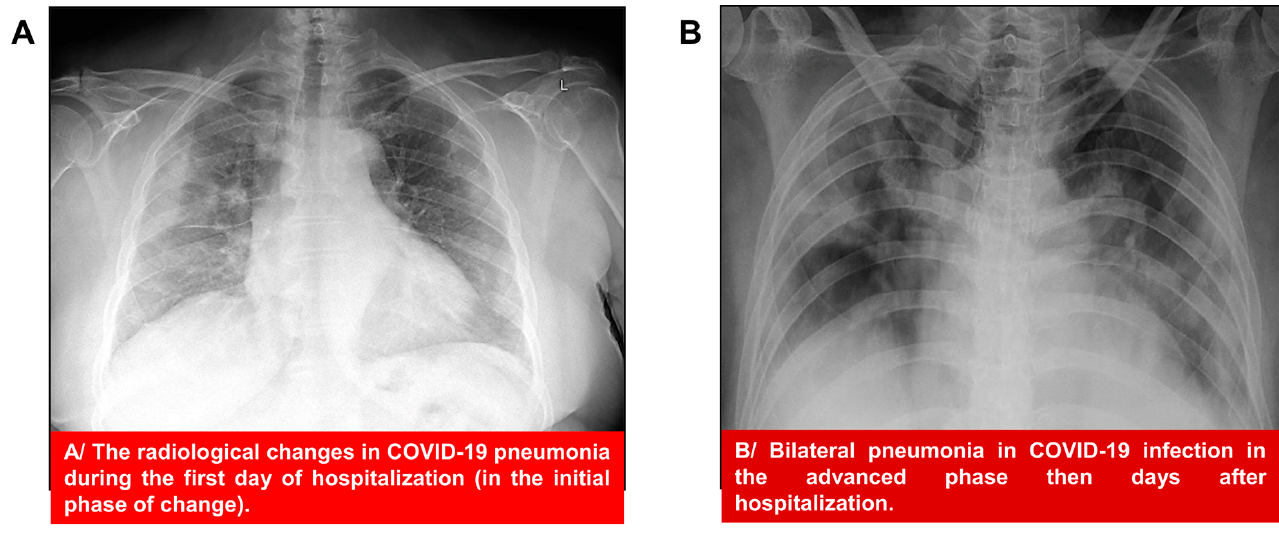
Figure 3. Chest radiography on PCR showed a COVID-19 positive patient: ( A ) COVID-19-induced bilateral pneumonia in the initial phase of changes. The radiograph was taken on the day of hospitalization (the day of the positive PCR test) L: left; ( B ) bilateral pneumonia in advanced-stage COVID-19 infection—ten days after hospitalization.